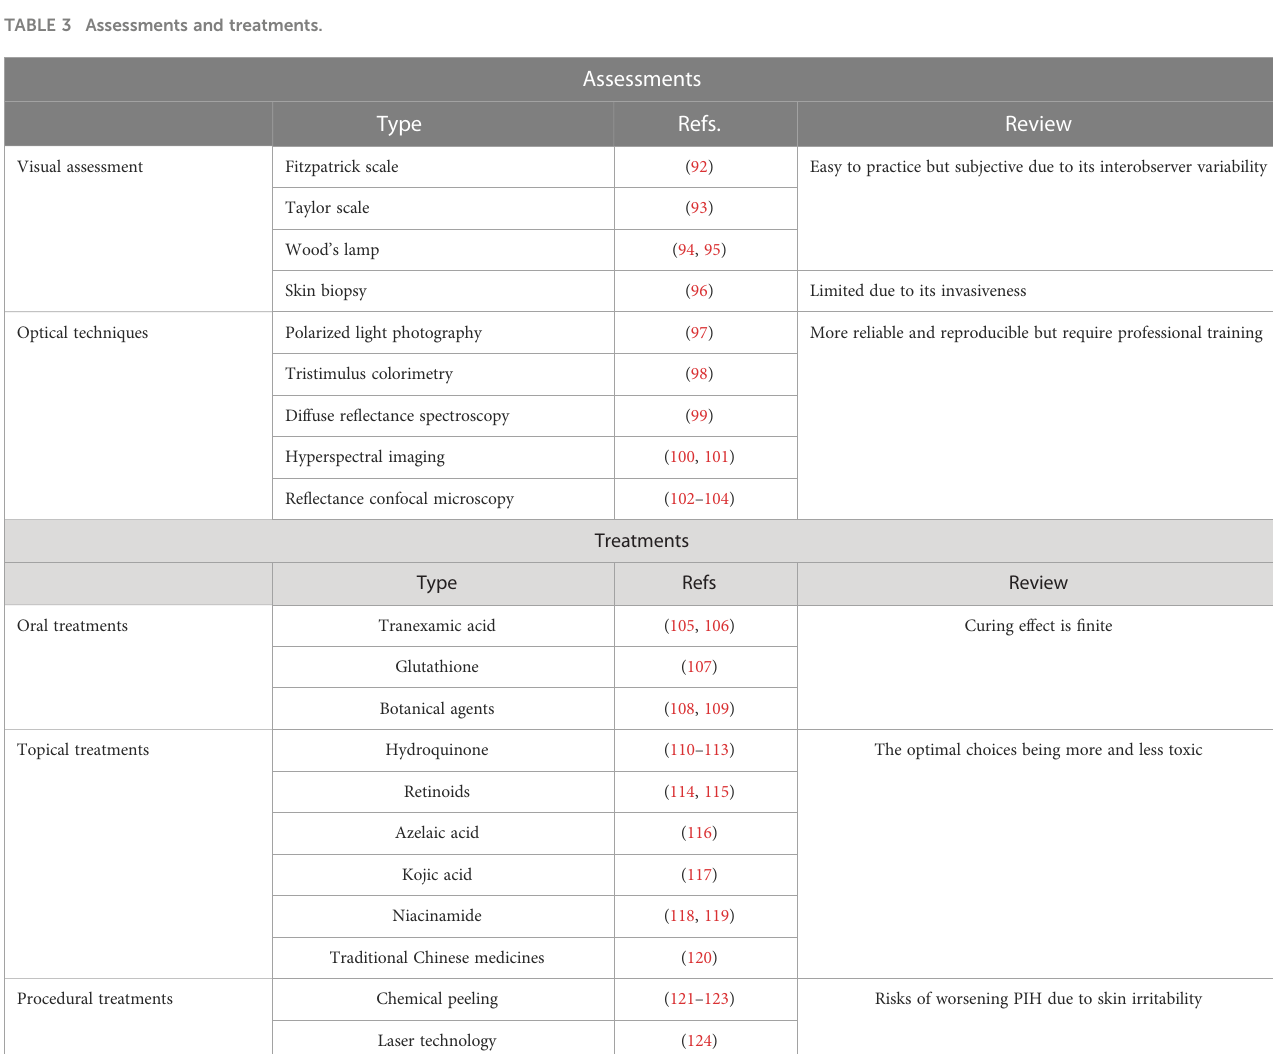
TABLE 3 Assessments and treatments.